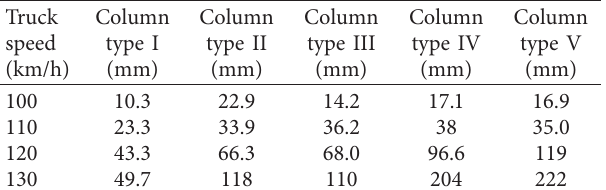
Table 6: Deformation of bridge column depending on impact speed.